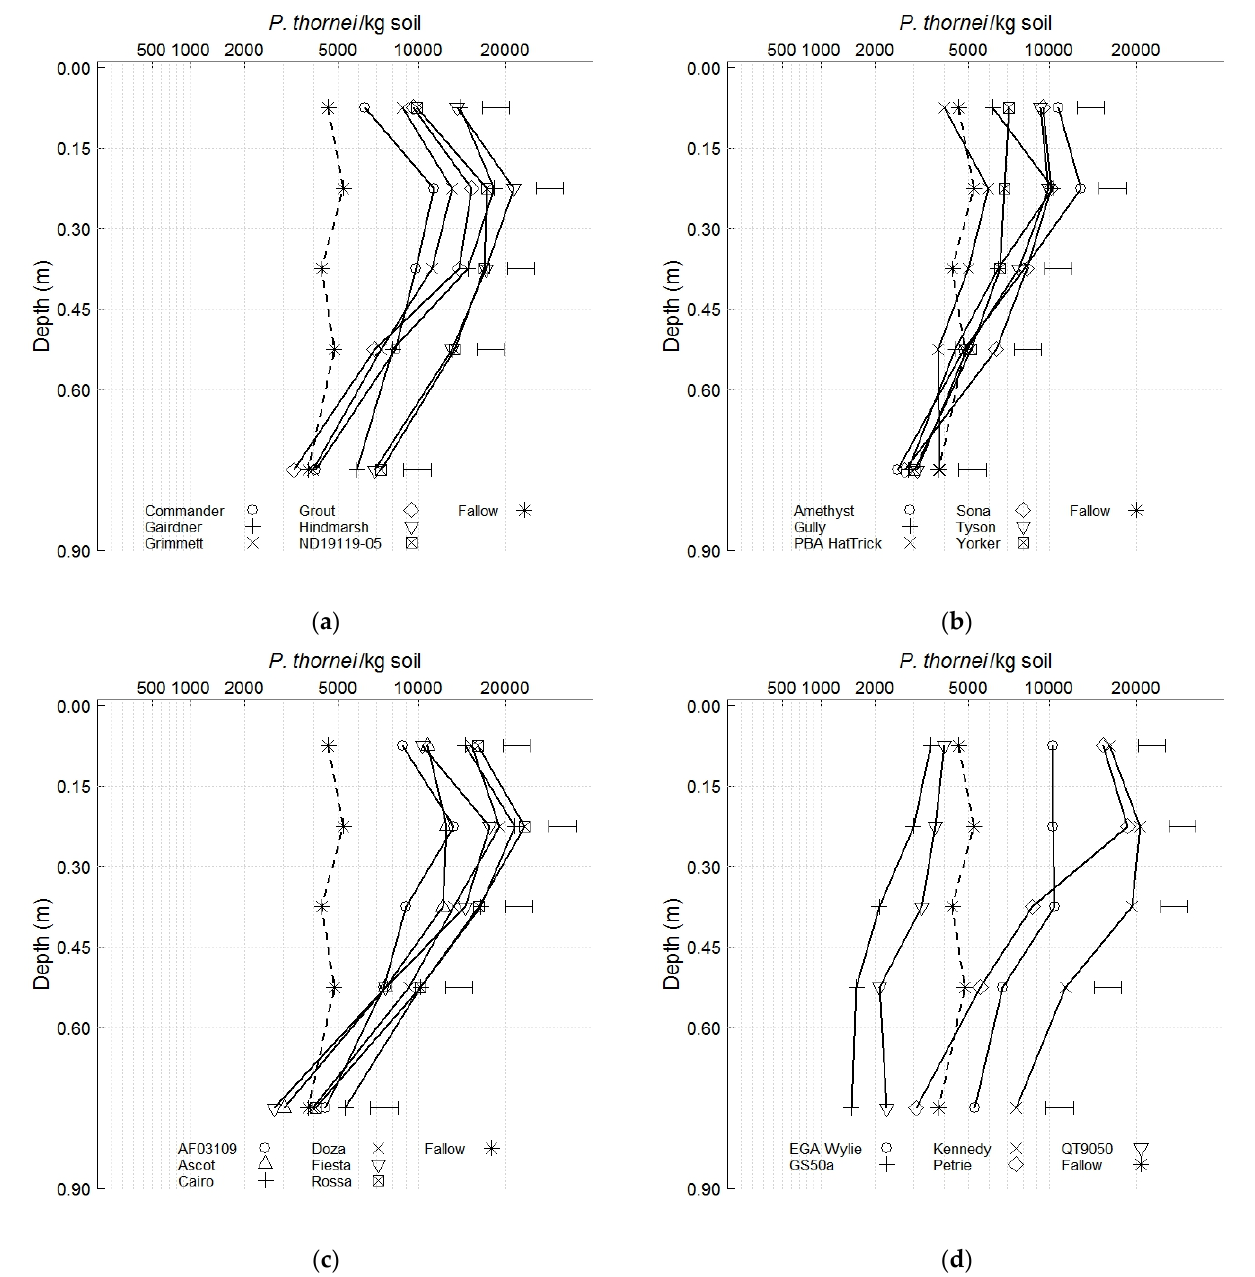
Figure 1. Pratylenchus thornei /kg soil to 0.9 m soil depth 6 months after harvest of the Phase 1 crops (2 months prior to sowing the Phase 2 wheat) for cultivars of ( a ) barley, ( b ) chickpea, ( c ) faba bean, and ( d ) wheat; with the weed-free fallow treatment shown in each figure as a broken line. Means from analysis across the two experiments are presented. Points are plotted on the transformed scale with the back-transformed means indicated on the horizontal axis. Bar markers represent, l.s.d. ( p = 0.05) for each soil depth x first year cultivar interaction, n = 12; standard error of the mean for each data point are shown in Supplementary Table S3.